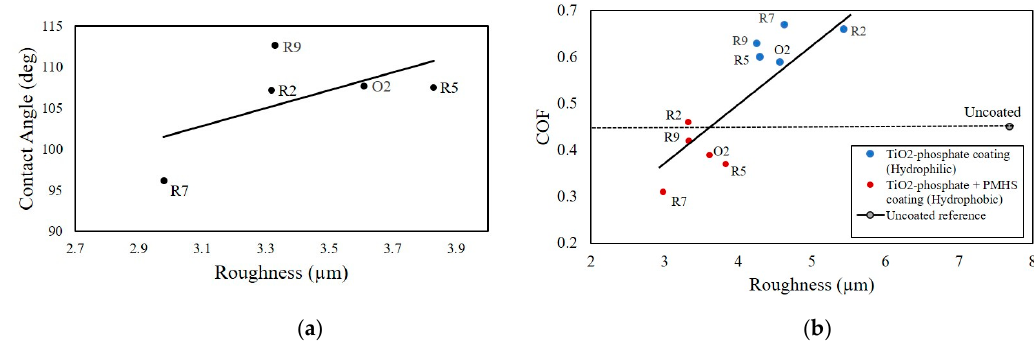
Figure 7. ( a ) Contact angle (CA) vs. surface roughness for hydrophobic tiles and ( b ) COF vs. roughness for hydrophilic and hydrophobic samples (reproduced from Reference [71] with permission).